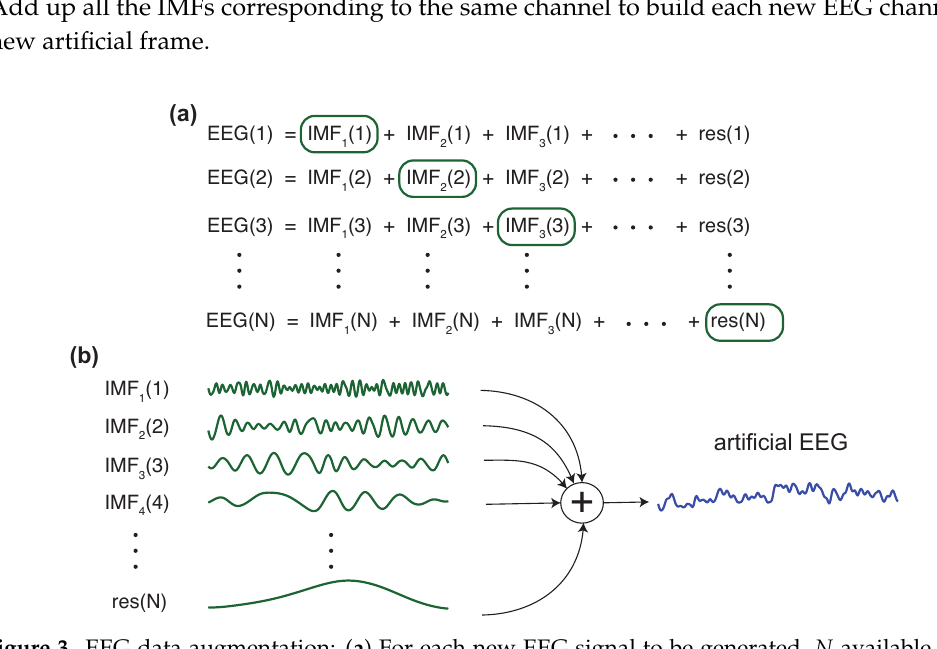
Figure 3. EEG data augmentation: ( a ) For each new EEG signal to be generated, N available EEG signals are randomly selected and their EMDs are computed. ( b ) To generate an artificial EEG signal, IMFs from different signals are